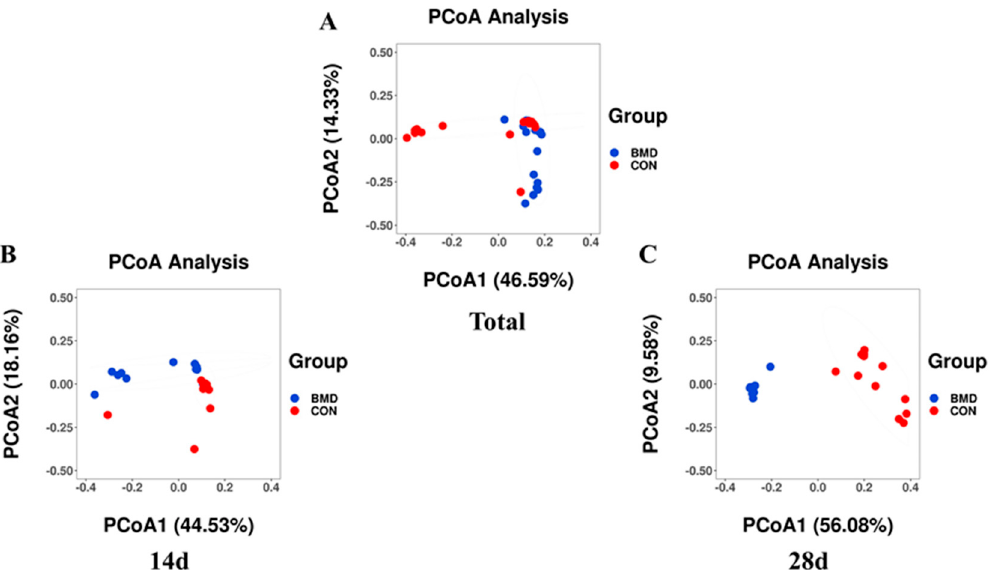
Figure 2. PCoA of the gut microbiota in the caecum on Day 14 (n = 24) and Day 28 (n = 23) in broilers. The caecal content of newly hatched broilers was measured on Days 14 and 28 after they were fed an unmedicated basal diet. An individual sample is represented by each data point. Based on 47 samples collected for each sampling day, PCoA was calculated ( A , B ) was calculated from 24 samples on each sampling day using relative abundance, and ( C ) was calculated from 23 samples on each sampling day using relative abundance. Statistical significance was determined using analysis of similarities (ANOSIM) and indicated in each plot.